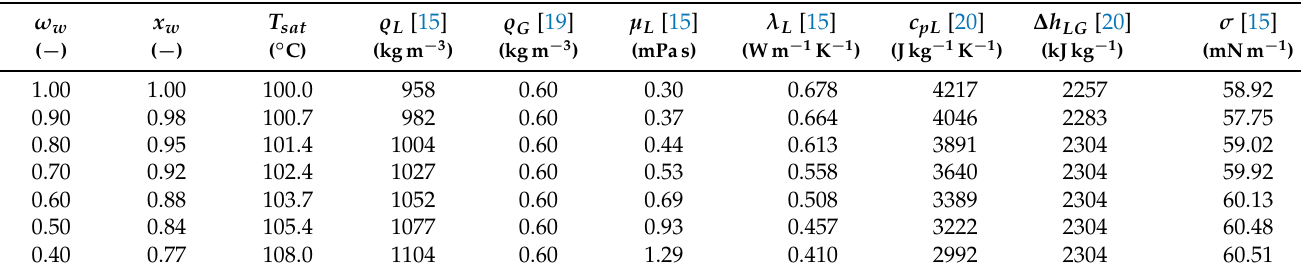
Table 1. Thermophysical properties of water–glycerin mixtures.